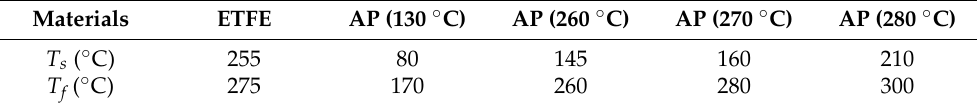
Figure 4. Thermomechanical curves of the neat ETFE and aluminum polyphosphate synthesized at 130 °C (1), 260 °C (2), 270 °C (3) and 280 °C (4). Table 2. Softening temperature ( T s ) and flow temperatures ( T f ) of ETFE and AP synthesized at different temperatures (average absolute deviation of 5 °C for each T s and T f ).